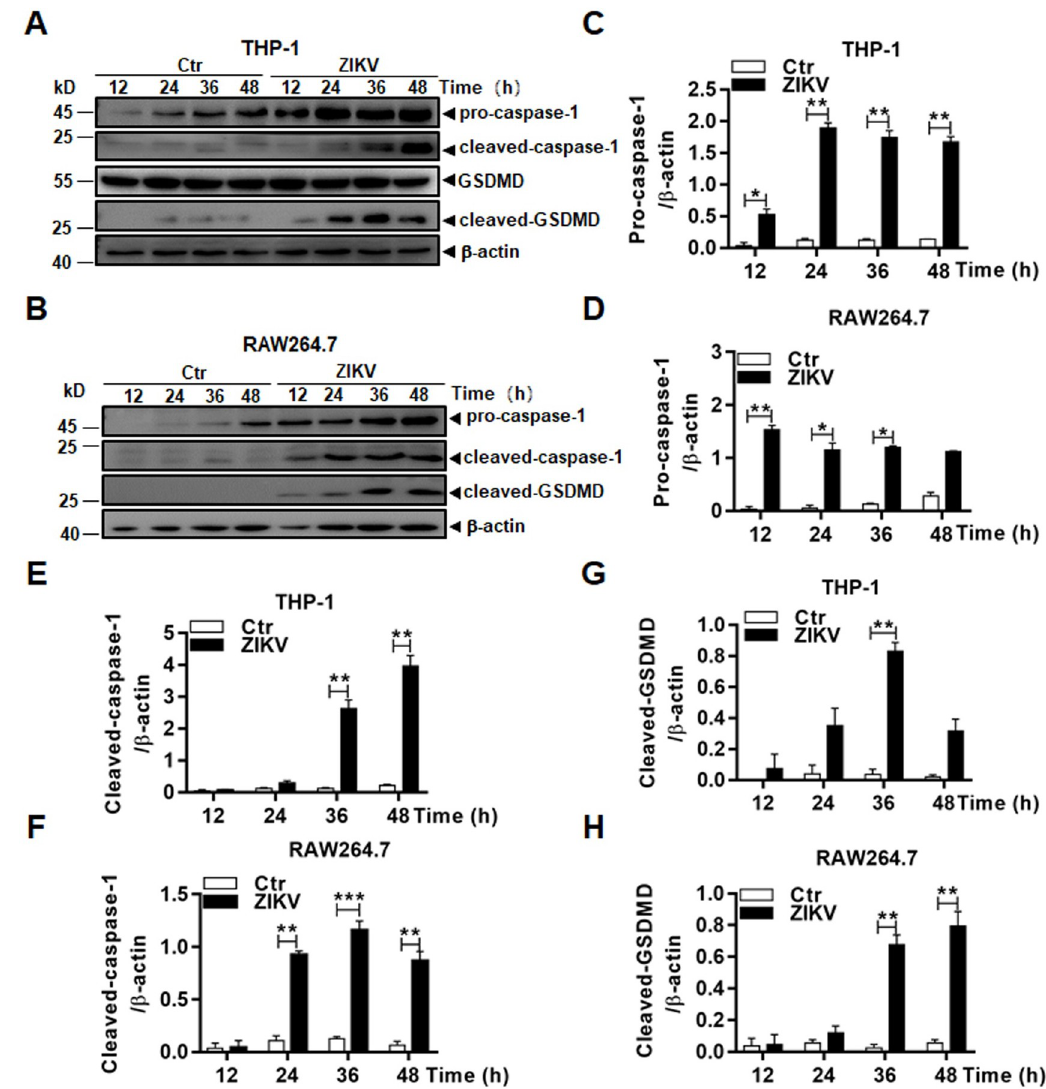
Fig 6. Inflammasome activation led to pyroptosis in ZIKV-infected macrophages. Cell lysates, prepared at various time points p.i. from THP-1 ( A ) and RAW264.7 ( B ) cells infected with 0.1 MOI of ZIKV, were analysed by western blot analyses with antibodies for pro- or cleaved caspase-1 and GSDMD. Quantitative analyses of the grayscale values in the blots of the pro- and cleaved caspase-1 and GSDMD in infected and control THP-1 ( C , D , & F ) and RAW264.7 ( E , G , & H ) cells were shown. The experiments were performed in triplicates and the data were shown as mean+SD, analyzed by unpaired Students t-test. � , P < 0.05; �� , P <